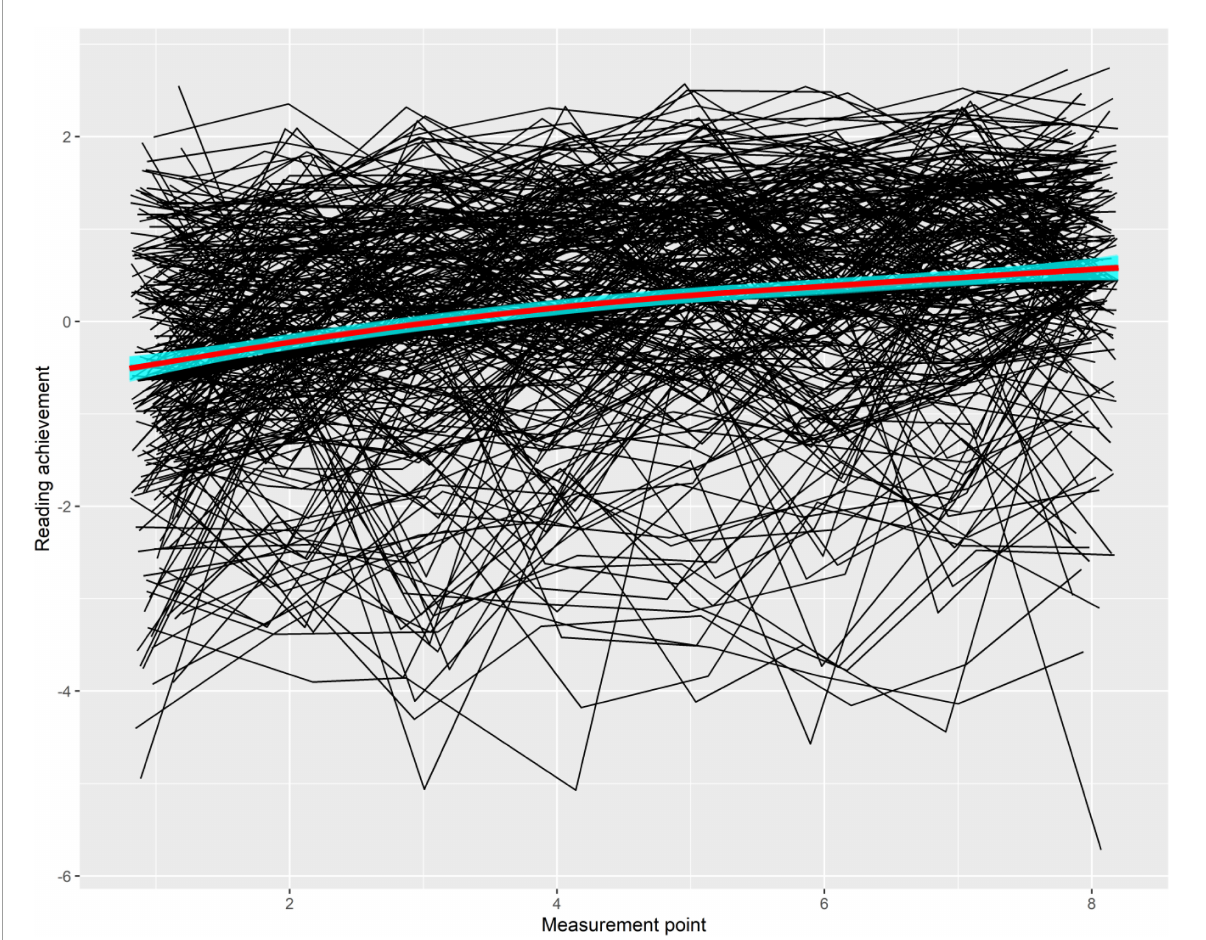
FIGURE6 Spaghetti plot for learning growth trajectory of students. We chose trajectories of n = 300 students at random to increase the interpretability of the plot. Red line represents LOESS-smoothed average growth trajectory. Standard error band is shown in